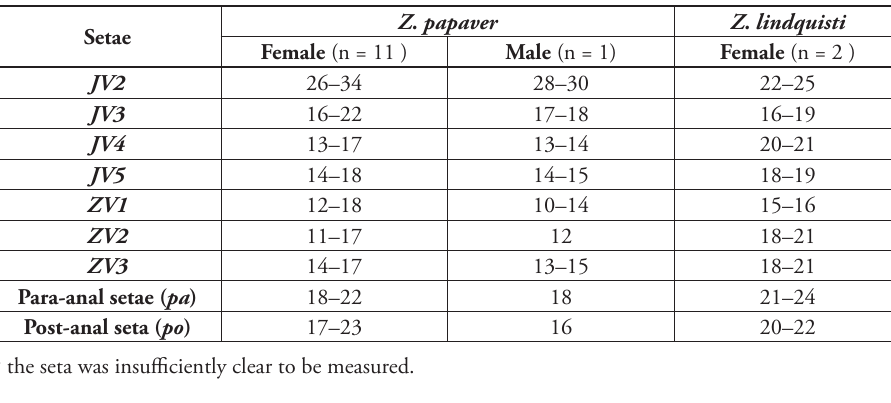
ibly fragmented apically into a platelet, itself abutting subtriangular exopodal plate between coxae I and II; shield anterior margin with a weak, wide median depression and two subtriangular projections; posterior margin narrow, truncate. Shield irregu- larly and sparsely micropuntate. A transverse, recurved linea posterad level of setae st1 . Metasternal platelets fused to endopodal elements, arc-like in shape, punctate, bearing simple setae st4 and poroids iv3 . Epigynal shield trapezoidal, 72–79 long, 22–27 long from st5 to posterior margin, 68–81 wide (length/width ratio: 0.91–1.03), with punc- tae most conspicuous in anterior and lateral portions; lineate posteriorly, three pairs of large subcircular sigillae centrally; anterior hyaline portion rounded, poorly